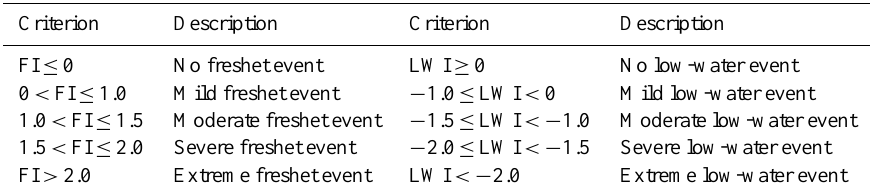
Figure 4. Spatial correlations of the observed (left) and generated (right) daily air temperature and precipitation in the study basin. Table 1. Definition of States of Freshet and Low-Water